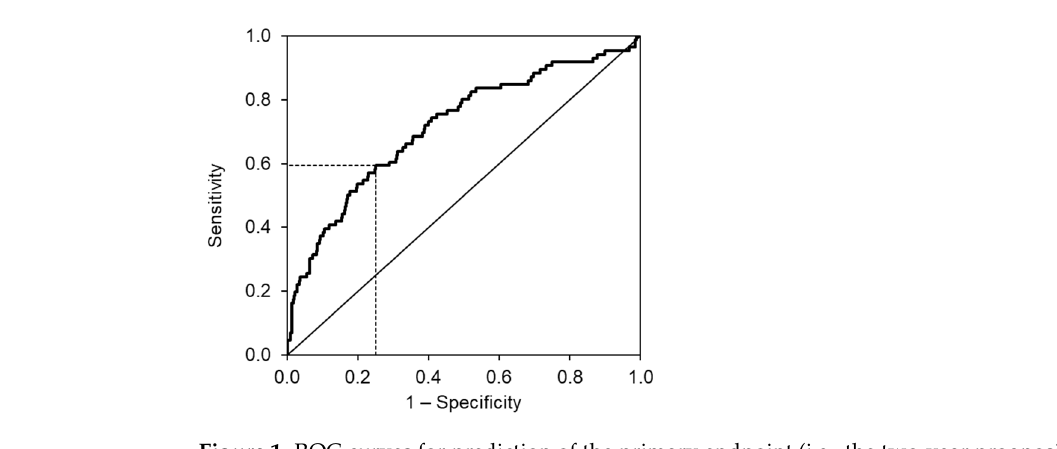
Figure 3. Distribution of MR-proADM level. Table 5. Dose of diuretics according to the level of MR-proADM. Parameter